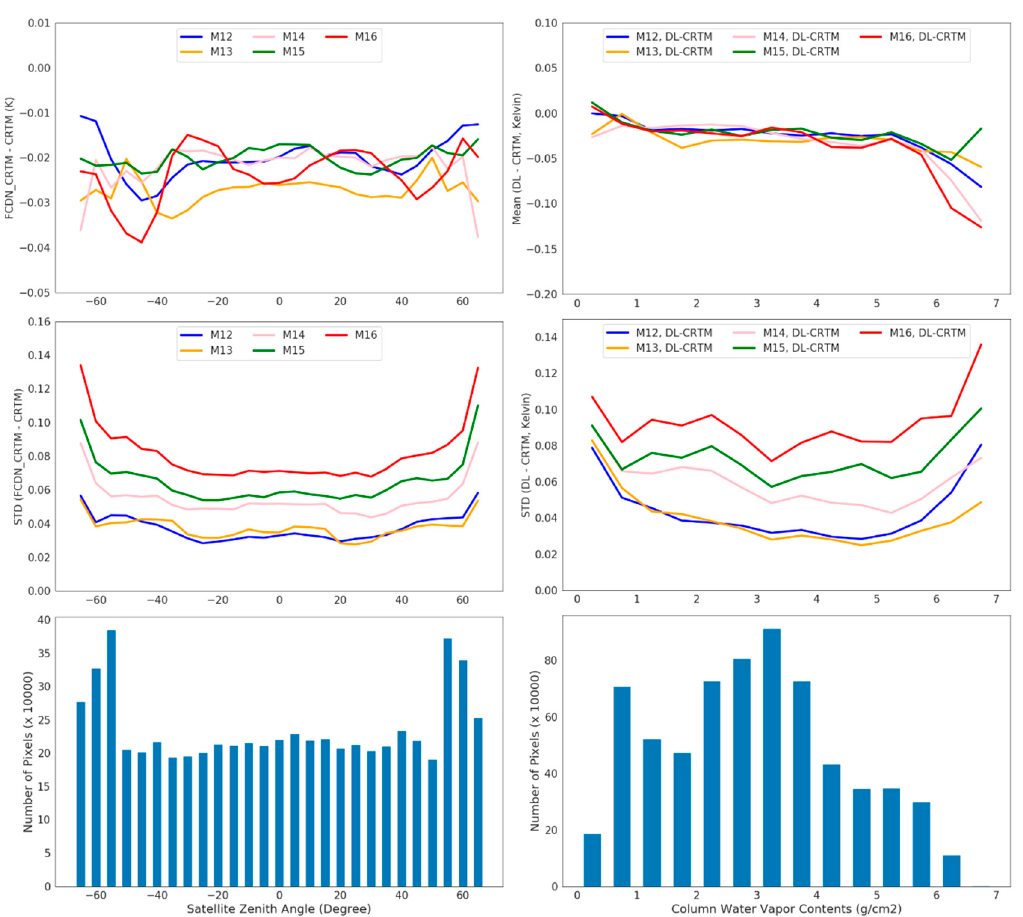
Figure 5. The F-C biases as functions of satellite zenith angle ( left panel ) and column water vapor ( right panel ) in VIIRS M12-M16 for 02 / 21 / 2020. ( upper panel ) F-C mean; ( middle panel ) STD; and ( bottom panel ) corresponding histogram.